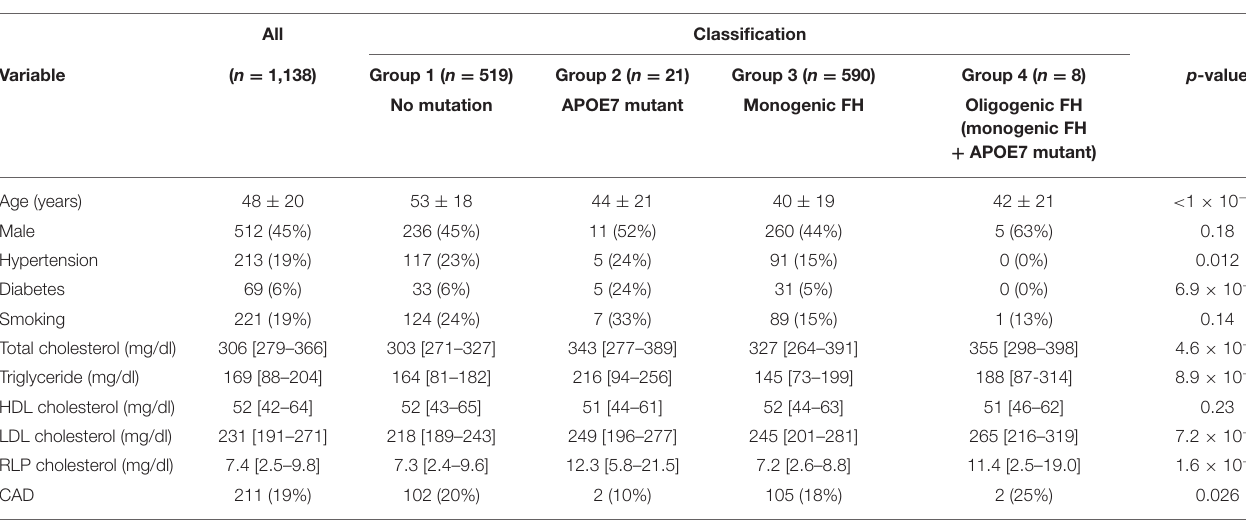
TABLE 1 | Characteristics of the